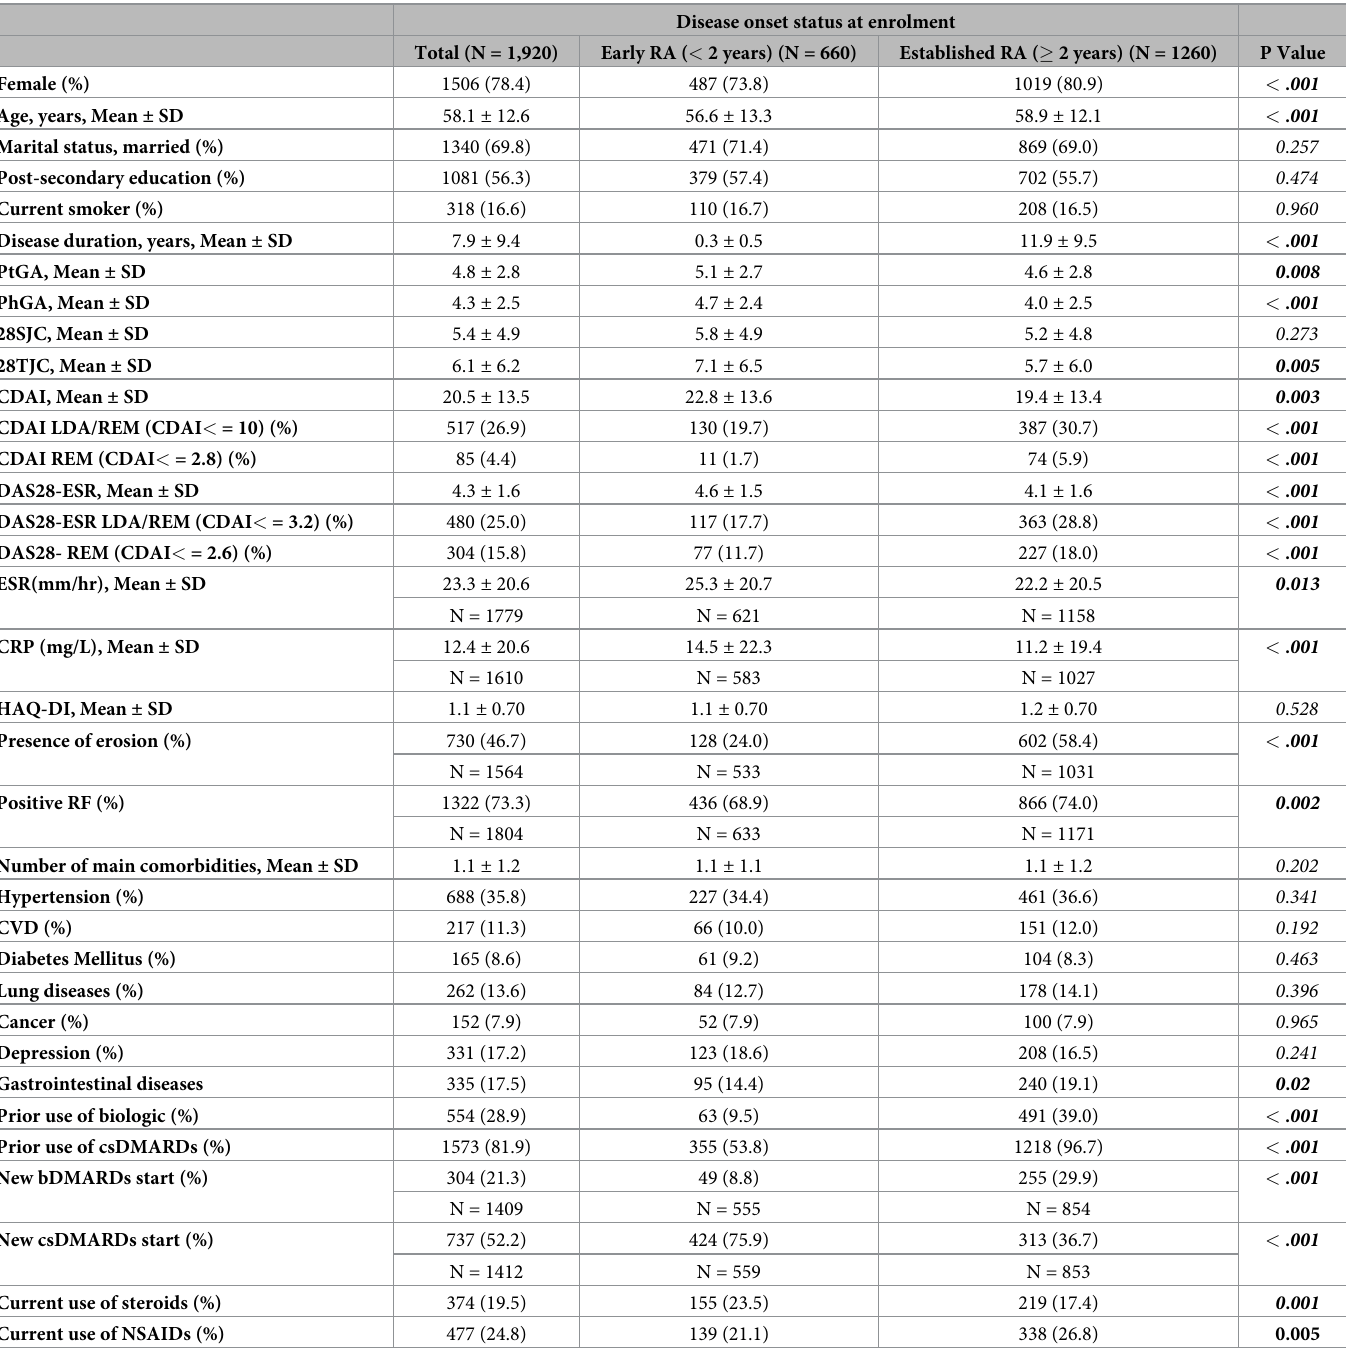
Table 1. Baseline characteristics of patients with